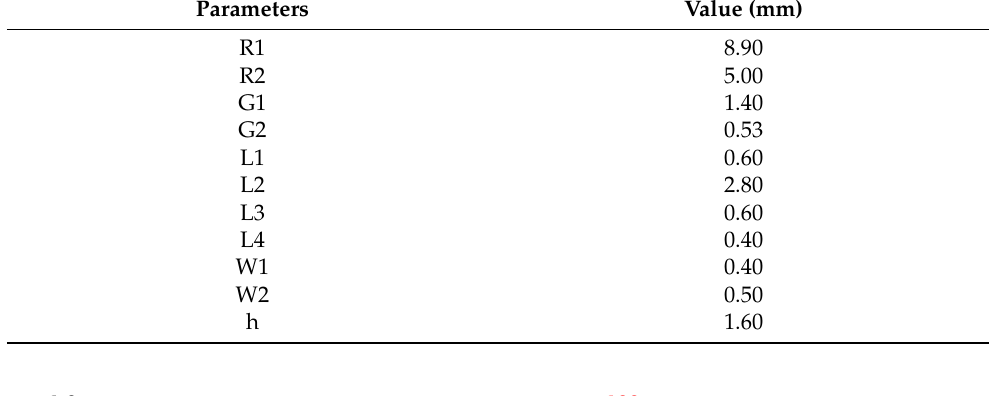
Figure 2. S-parameters and absorption property of the proposed MMA. Table 1. Parameter ’ s list of proposed MMA.